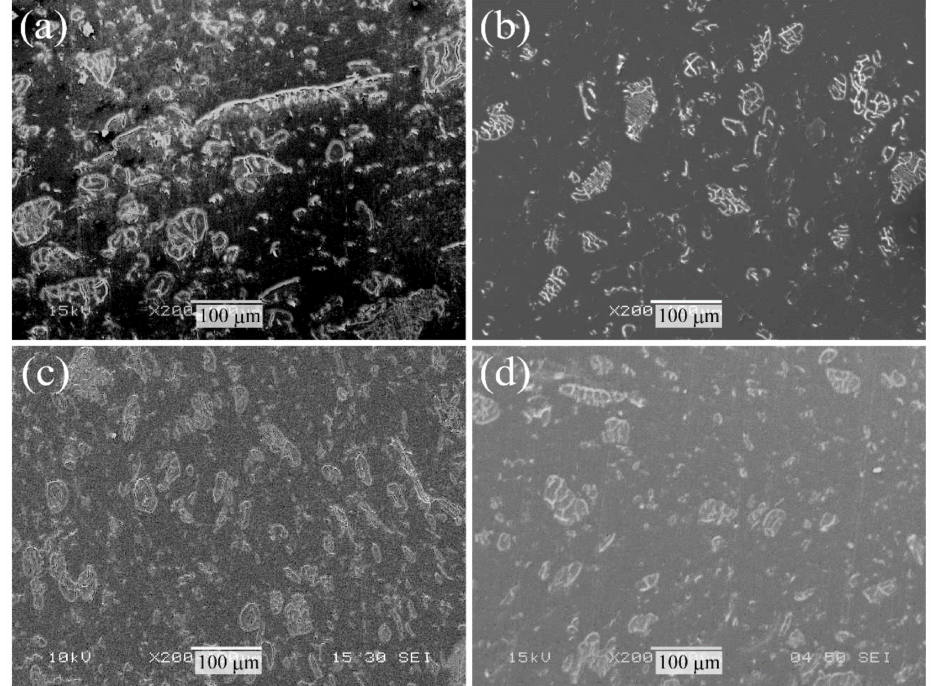
Figure 3. SEM photographs of the polished cross-sectional surface of various surface-treated HF/PA1010 biomass composites: ( a ) HF_NaClO 2 , ( b ) HF_NaClO 2 + EP, ( c ) HF_NaClO 2 + A-1160, and ( d ) HF_NaClO 2 + A-1160 + EP ( ×